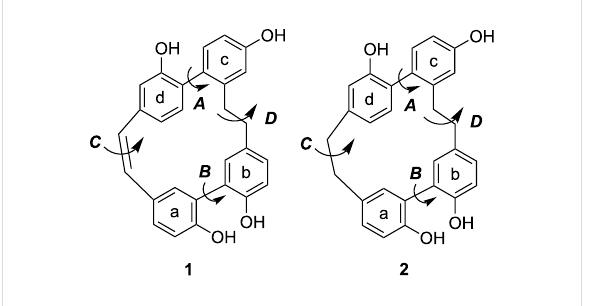
Figure 1: Structures of isoplagiochins C ( 1 ) and D ( 2 ) (with aryl frag- ments a–d and possible conformational barriers A – D